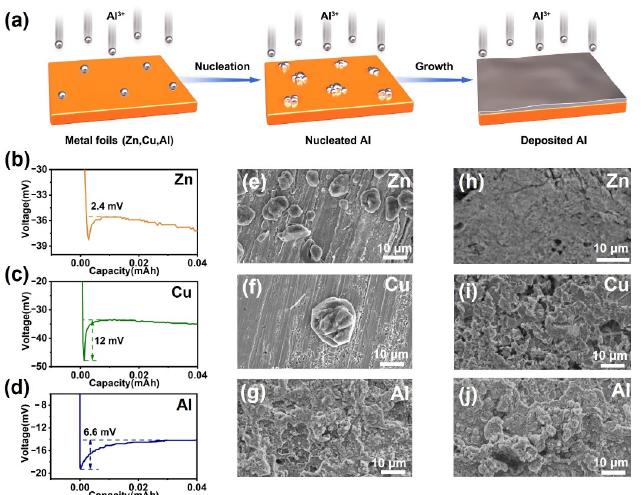
Figure 1. ( a ) Schematic diagram of nucleation and growth of Al deposited on different metal sub- strates. The nucleation curve of Al deposited on ( b ) metal Zn, ( c ) metal Cu and ( d ) metal Al. Scan- ning electron microscopy (SEM) images of deposited Al on metal foils, including ( e ) Zn, ( f ) Cu and ( g ) Al after depositing 0.1 mAh·cm − 2 of Al. SEM images of deposited Al on ( h ) Zn, ( i ) Cu and ( j ) Al after depositing 2 mAh·cm − 2 of